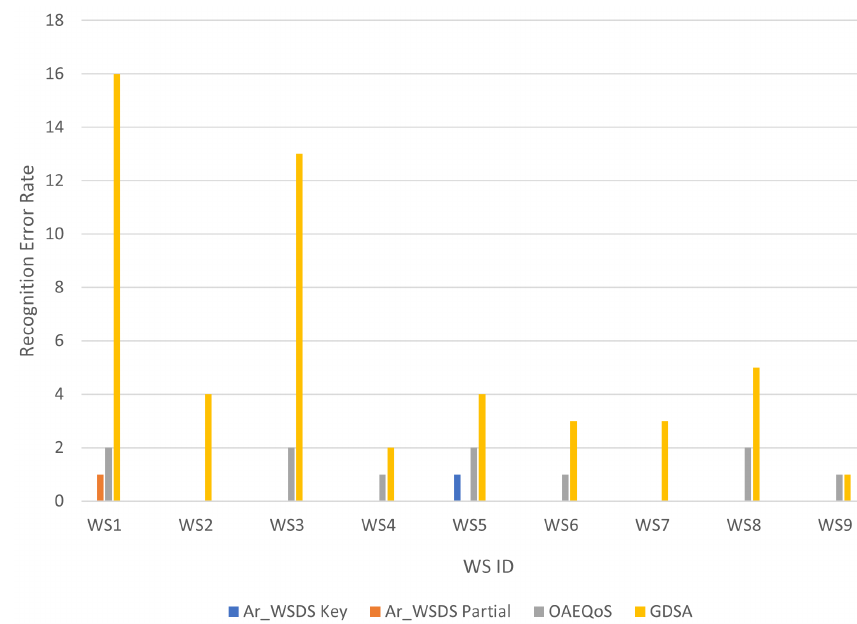
Figure 12. Error rate in the selection process according to the various